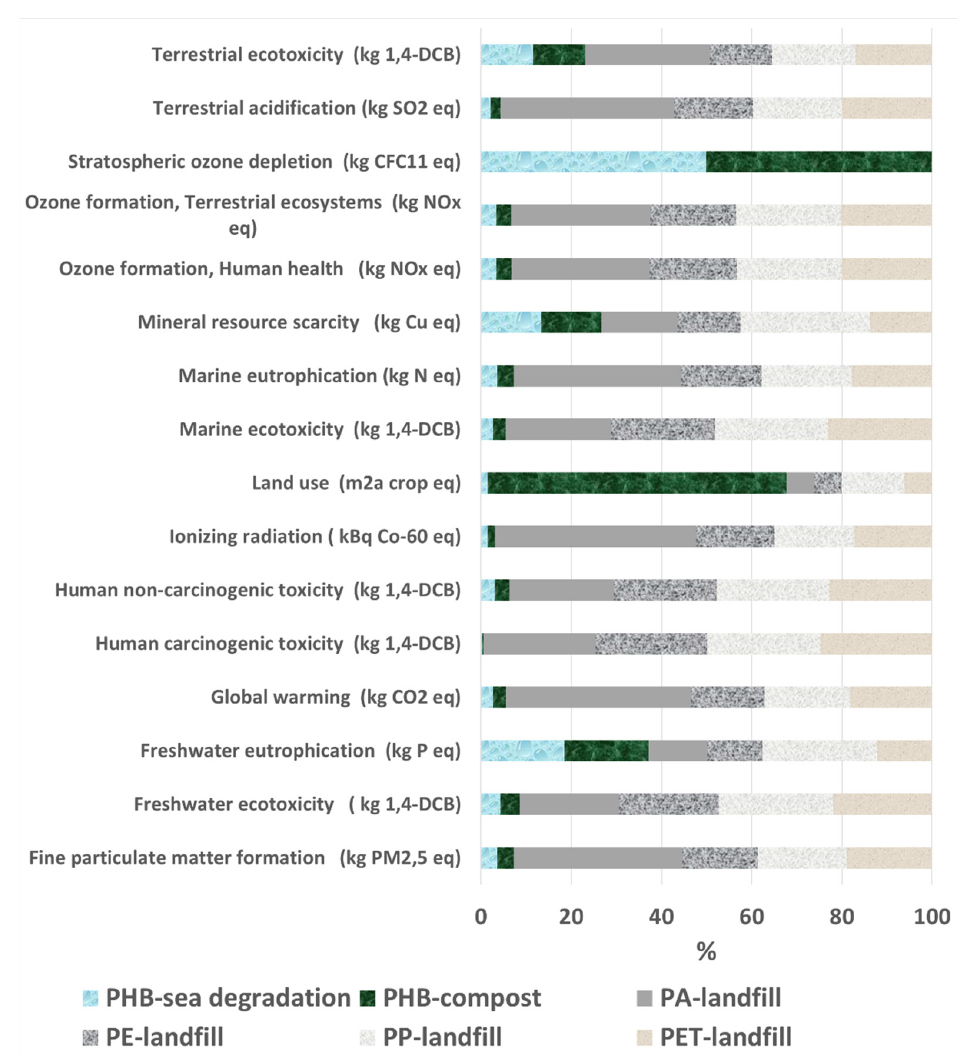
Figure 12. Relative contribution of cases “a”, “b” and “c” (%) to the quantified environmental impacts obtained using Recipe 2016 Midpoint.